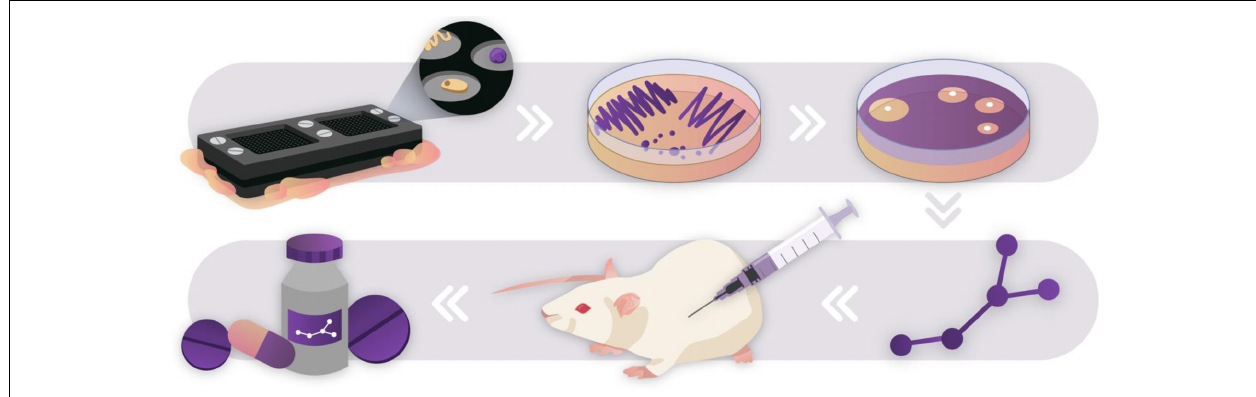
FIGURE 3 | Drug discovery pipeline through culturing the “unculturable.” The ichip was used to culture novel species in an environmental soil sample (Ling et al., 2015). Species that successfully passaged onto agar plates were used to screen for antibiotic activity against S. aureus. Bioactive compounds were extracted, purified, characterized, and tested in vitro against a multitude of pathogenic organisms. This pipeline led to the discovery of teixobactin, a novel antibiotic compound that showed no mutants acquiring resistance against it in preliminary testing. After discovery, novel drugs go through rigorous safety and efficacy testing before they may be developed into safe consumer products. Novel discoveries such as this show the untapped potential of “Microbial dark